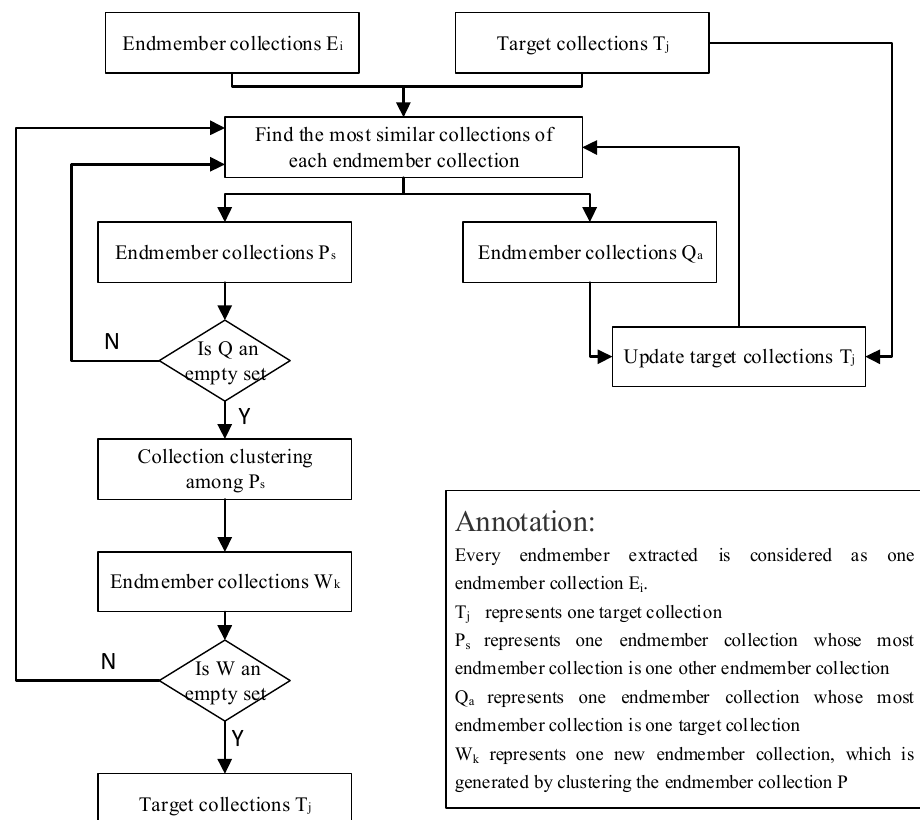
Figure 3. General flowchart of the SMSC clustering method.